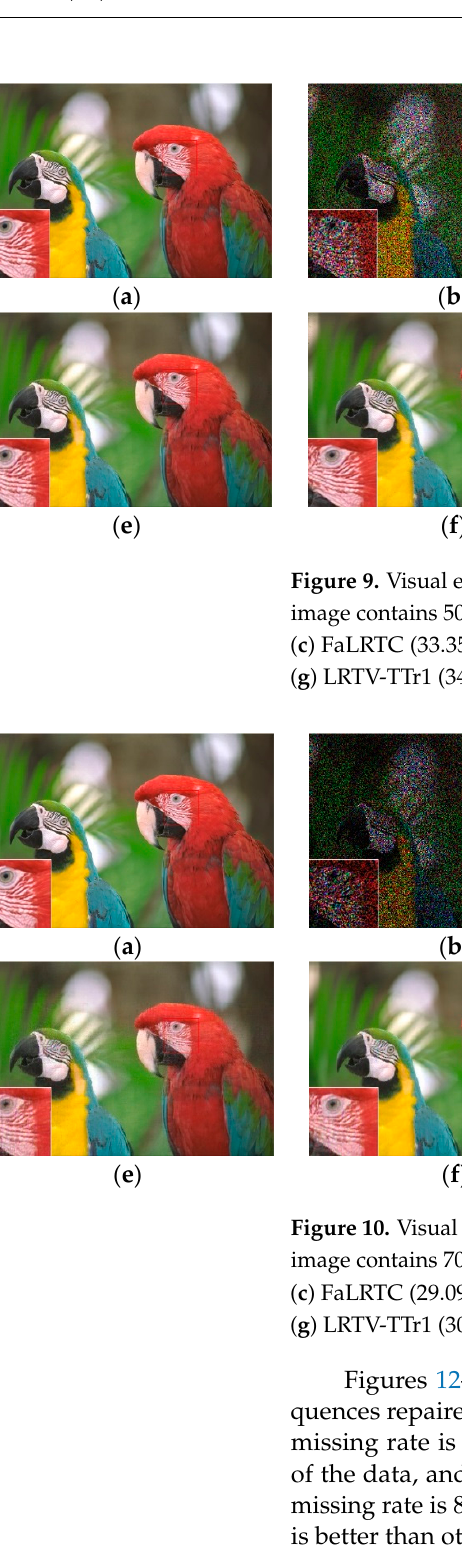
image contains 70% missing entries, shown as black pixels. ( a ) Original image; ( b ) Incomplete im-